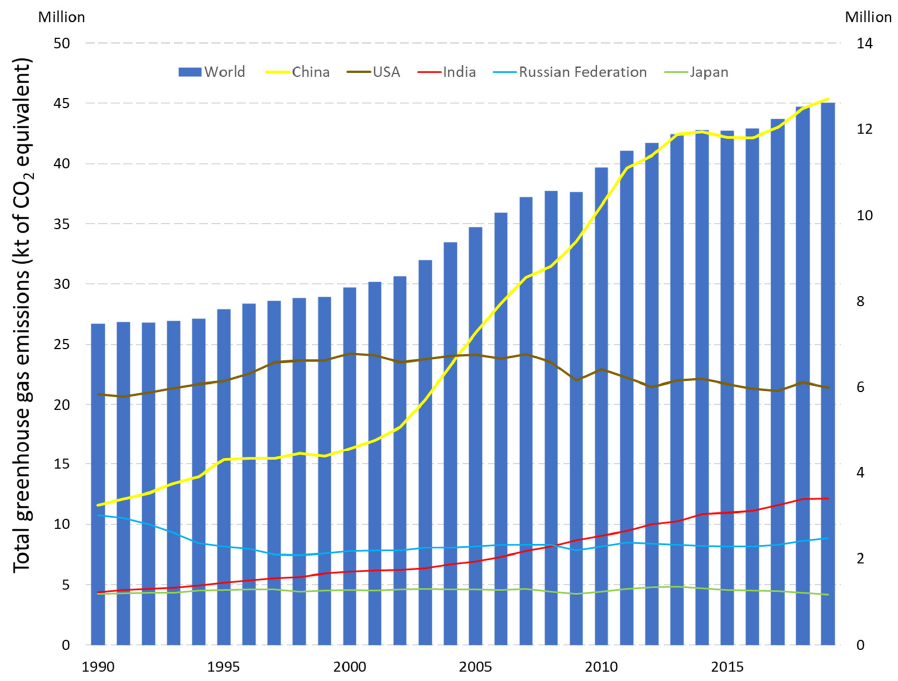
Figure 1. Representation of the total greenhouse gas emissions in the world, China, USA, India, Russian Federation, and Japan. Bar chart shows the emissions worldwide, line graphs show the emissions in China, USA, India, Russian Federation, and Japan with appropriate values on the left and on the right, respectively (based on online databases in World Bank Data [8]).